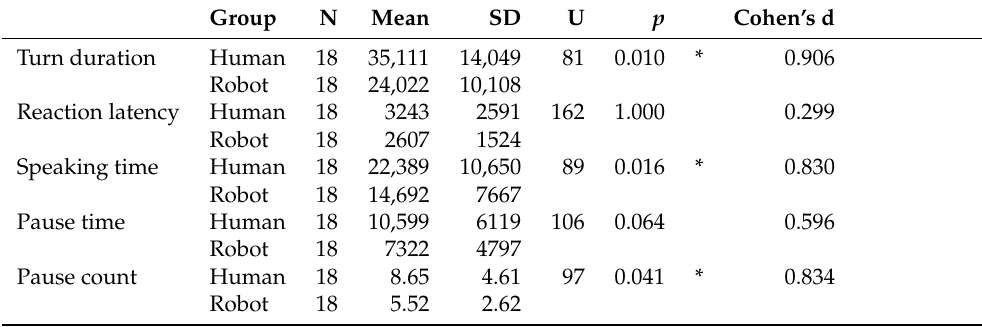
Table 1. The summary of the descriptive statistics values and the analysis results of participants’ speeches. The symbol * means that the p-value is lower than